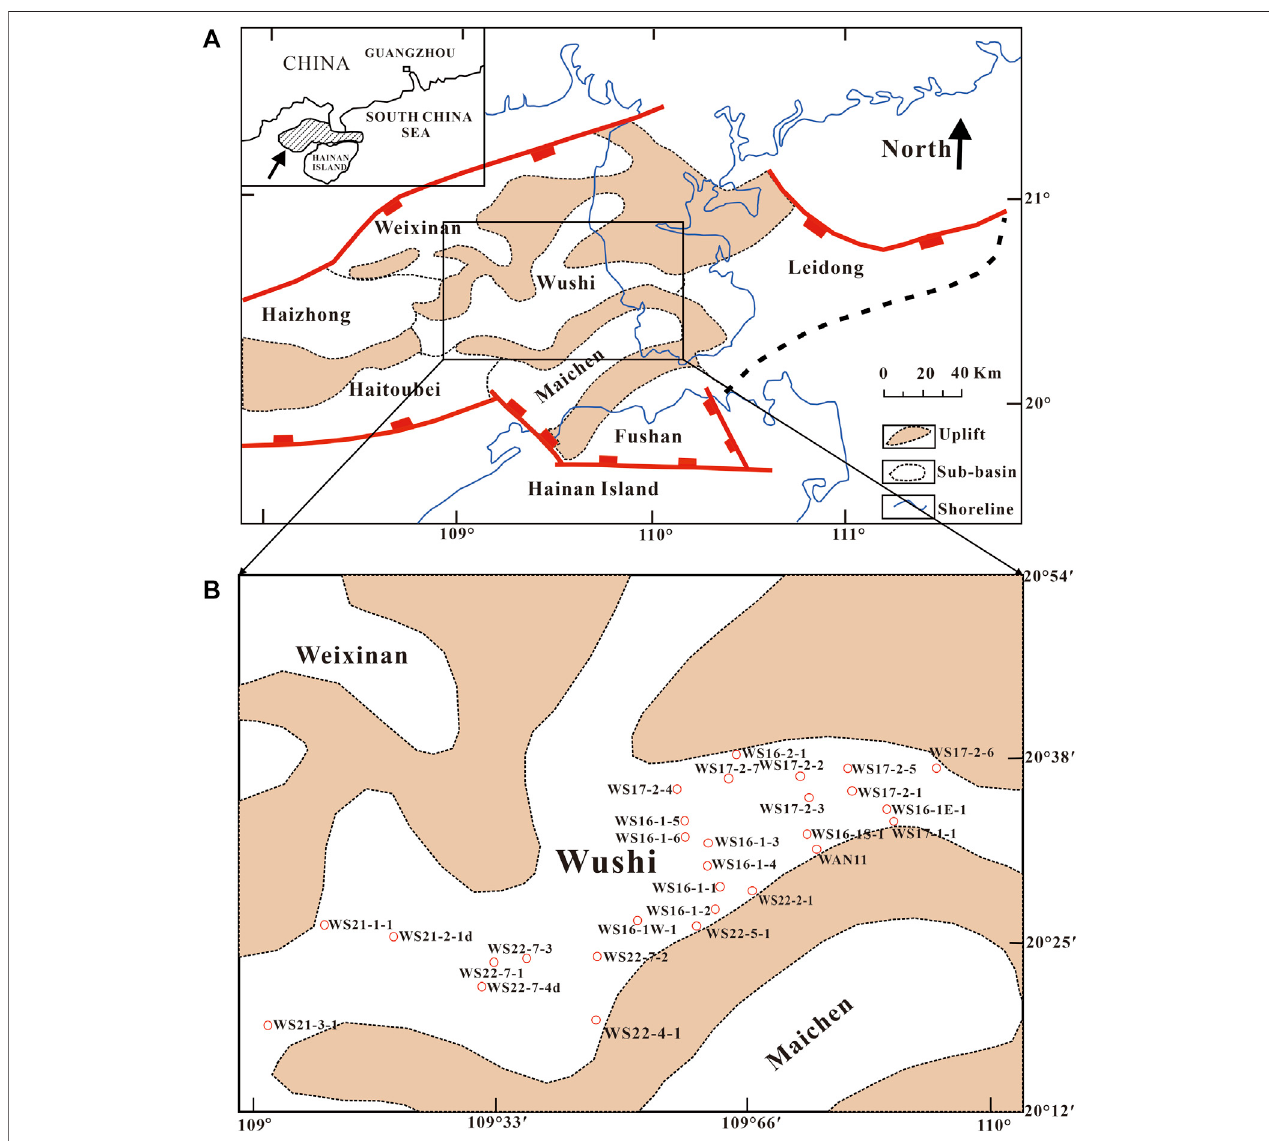
FIGURE1| Geologicalmapsshowing: (A) tectonicunitsoftheBeibuwanBasinandlocationoftheWushiSag,and (B) welllocationinthestudyarea[modi fi edafter (Huang et al., 2017)].